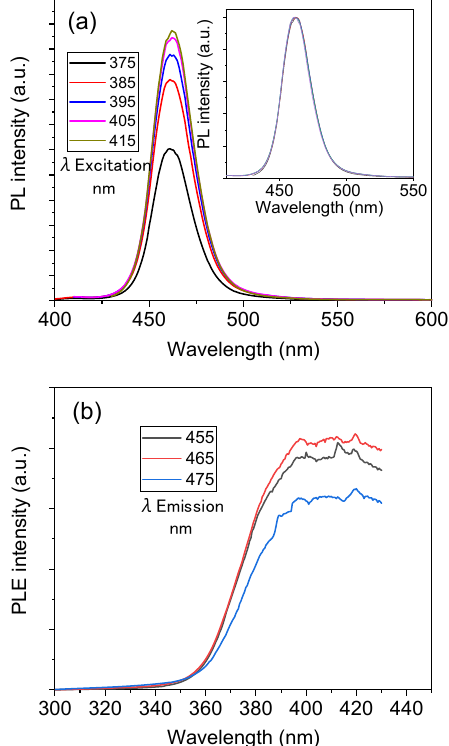
Figure 2. ( a ) Photoluminescent (PL) spectra excited at 375 to 415 nm with an interval of 10 nm. Inset: PL spectra excited at different wavelengths are normalized. ( b ) Excitation spectra monitored at emission wavelengths of 455, 465, and 475 nm.